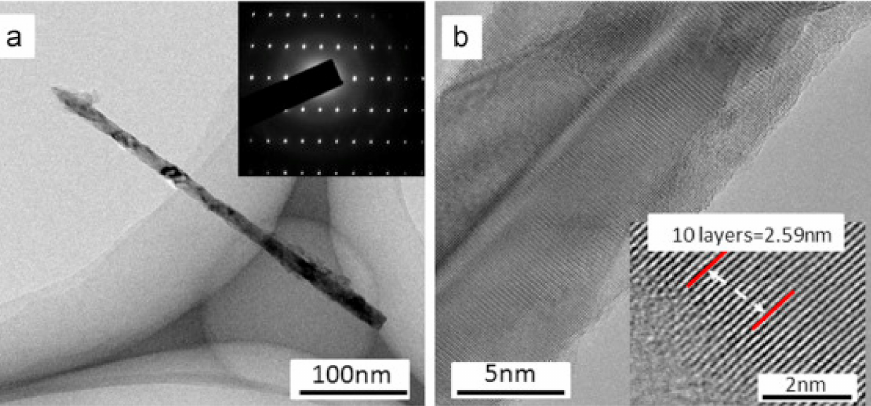
Figure 3. TEM images of nanowires on the GaN sample without metal coating and etched in AgNO 3 /HF for 50 min. ( a ) The image of a single nanowire. ( b ) The enlarged view of the nanowire in ( a ). Reproduced from [55], with permission from Copyright Elsevier,